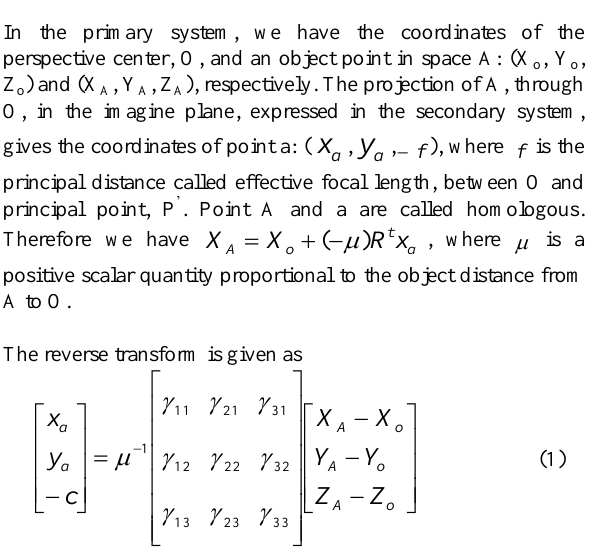
Figure 1. The central perspective projection